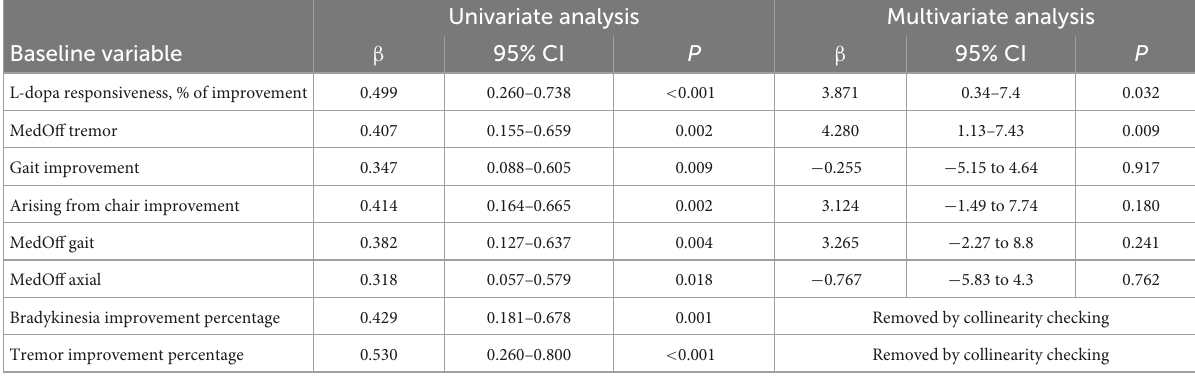
TABLE 5 Linear regression analysis identified factors influencing short-term motor outcome in the entire cohort.